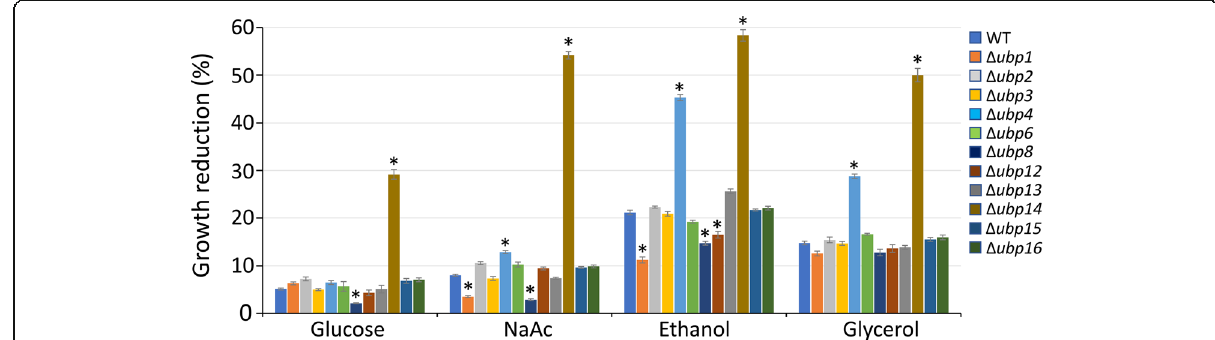
Fig. 9 Statistical analysis of growth reduction rates of colony growth on different carbon sources compared to growth on CM plates. The wild- type and ubp mutant stains cultured on CM or minimal medium agar containing 1% glucose, 50 mM sodium acetate, 50 mM ethanol, or 50 mM glycerol for 120 h at 28 °C. Means and standard errors were calculated from three independent replicates. Significant differences were indicated by asterisks ( P <